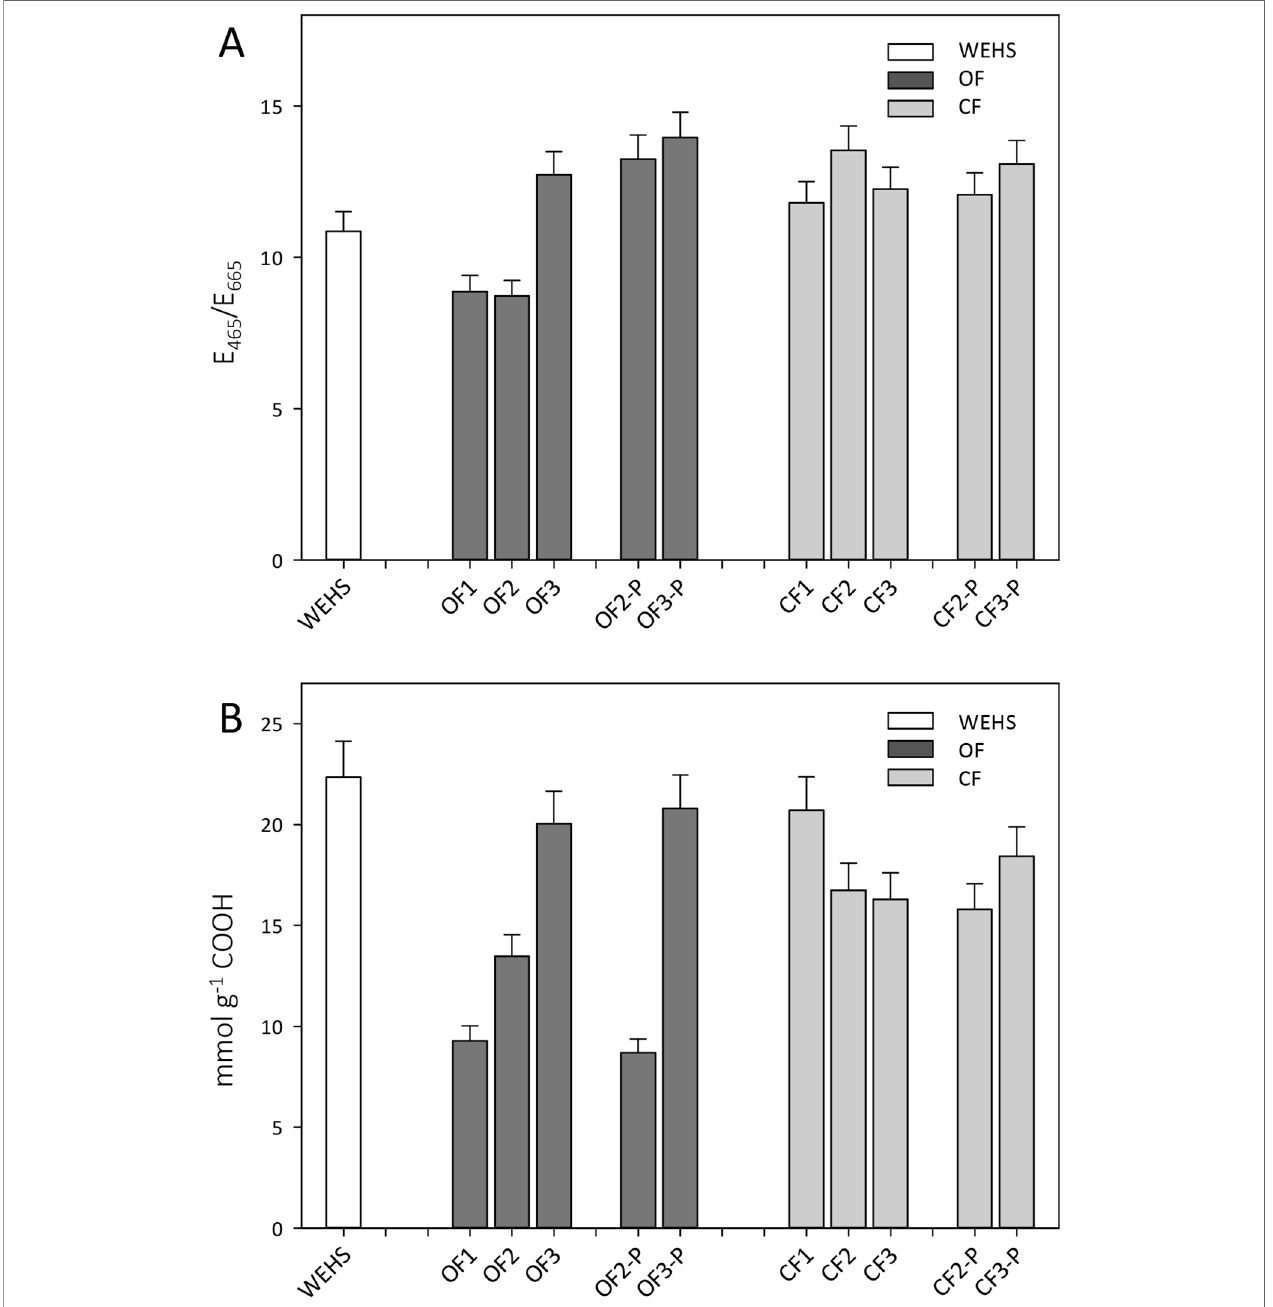
FIGURE 6 | E 465 / E 665 ratios of organic farming (OF) and conventional farming (CF) fractions (A) and density of carboxylic groups in dissolved humic substances (DHS) obtained by titration with NaOH 0.1 M (B) . White bar refers to water-extractable humic substances (WEHS); dark gray bars refer to DHS isolated from OF soils; light gray bars refer to DHS isolated from CF soils (data shown are means plus standard deviation). OF1 and CF1 were sampled in November; OF2, OF-P2, CF2, and CF-P2 were sampled in April; OF3, OF-P3, CF3, and CF-P3 were sampled in June. OF1, OF2, OF3 and CF1, CF2, CF3 refer to leachates collected